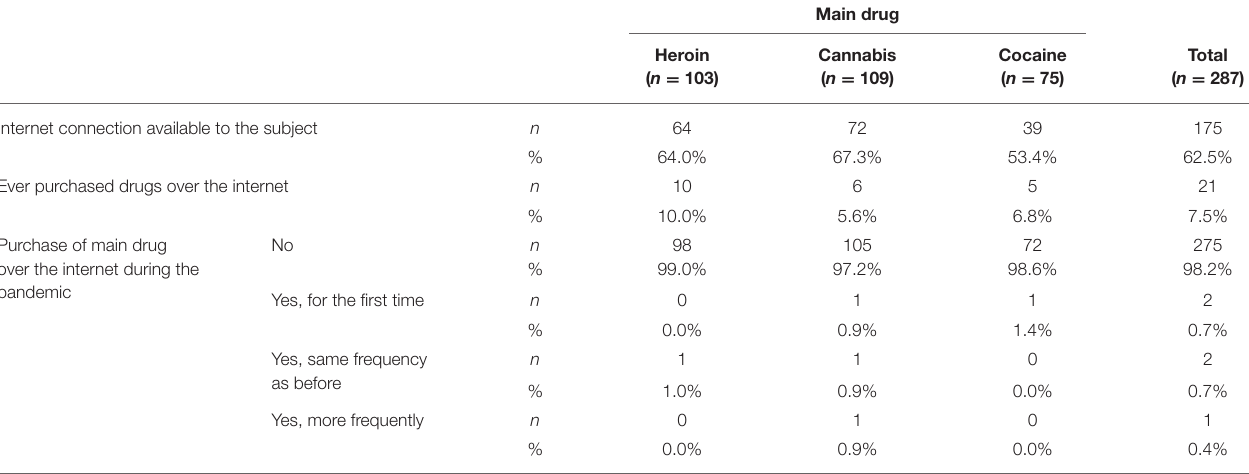
TABLE 3 | Online acquisition of illicit